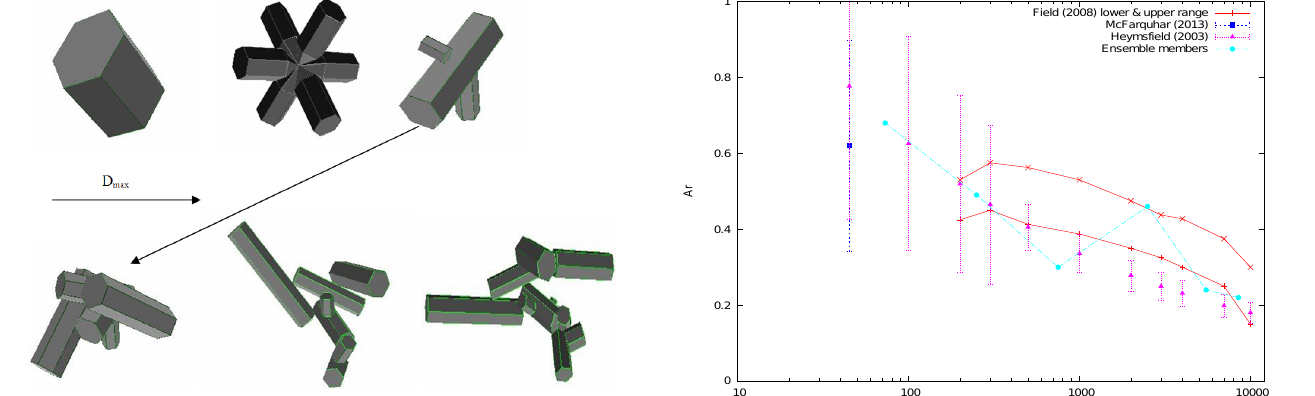
Figure 3. The ensemble model area ratio, A r , as a function of ice crystal diameter or D max . The key is shown on the upper right-hand side of the figure. The members of the ensemble model are repre- sented by the filled cyan circles. The in situ observations are from Field et al. (2008) (red lines), where the plus and cross signs rep- resent the lower and upper range of those observations and those ranges have an uncertainty of ± 30%. The blue error bar repre- sents the mean and range of observations taken from McFarquhar et al. (2013) and the purple error bars represent the uncertainty in the observations taken from Heymsfield and Miloshevich